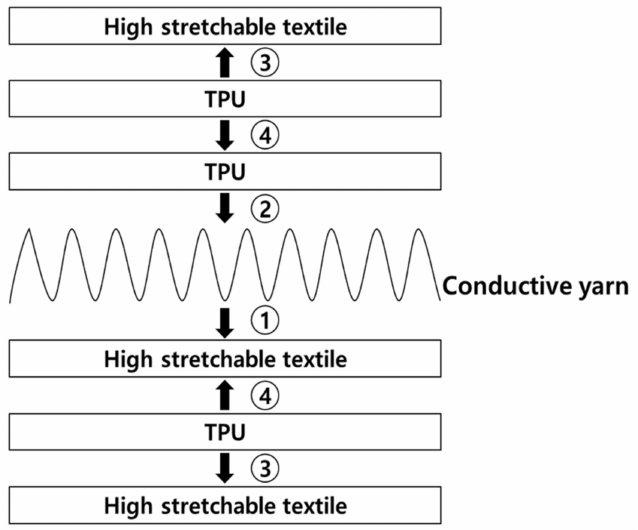
Figure 4. Positive temperature coefficient surface heating textile (PTC-SHT) assembly conducted in four steps. 1 (cid:13) electrode patterning and screen printing, 2 (cid:13) TPU film bonding, 3 (cid:13) External textile preparation (TPU film bonding), 4 (cid:13) Bonding of inner and outer textiles.